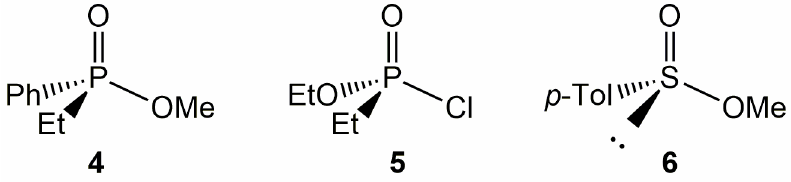
Figure 1. Structures of model compounds used in our studies on identity